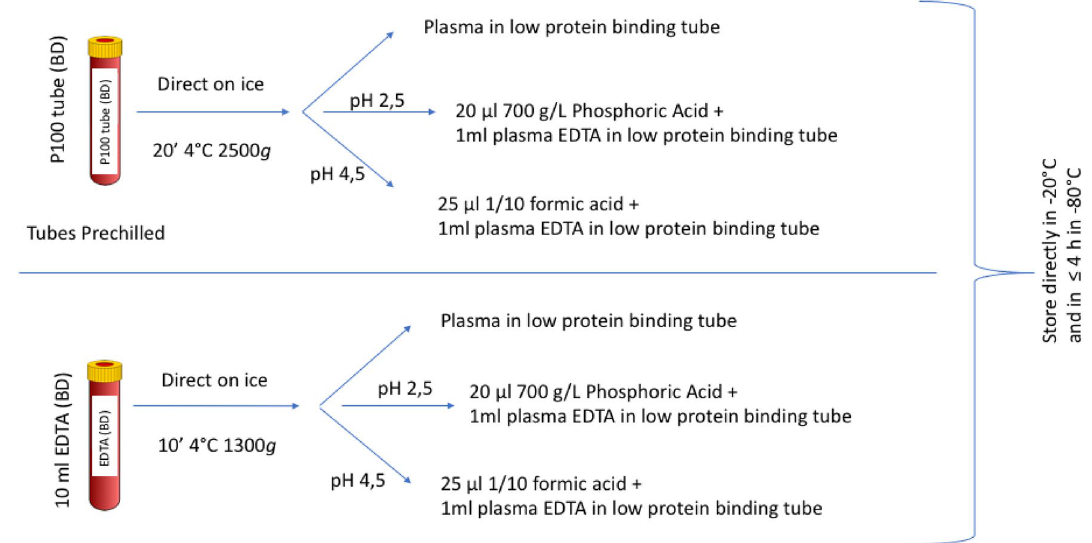
Figure 3. Overview of preanalytical conditions. Samples were immediately cooled on ice and processed within 1 h. Both standard K 2 EDTA tubes and P100 prechilled tubes containing a protease inhibitor cocktail and mechanical separator were used. The standard K 2 EDTA was centrifuged for 10 min 1300 × g at 4 °C, while the P100 tube was centrifuged for 20 min 2500 × g at 4 °C, according to the manufacturers’ instructions. After separation, plasma was untreated or acidified to either pH 2.5 or 4.5 by adding the plasma to low protein- binding tubes pre-filled with either phosphoric acid or formic acid. The plasma samples were stored directly at − 20 °C and transferred within 4 h at − 80 °C.